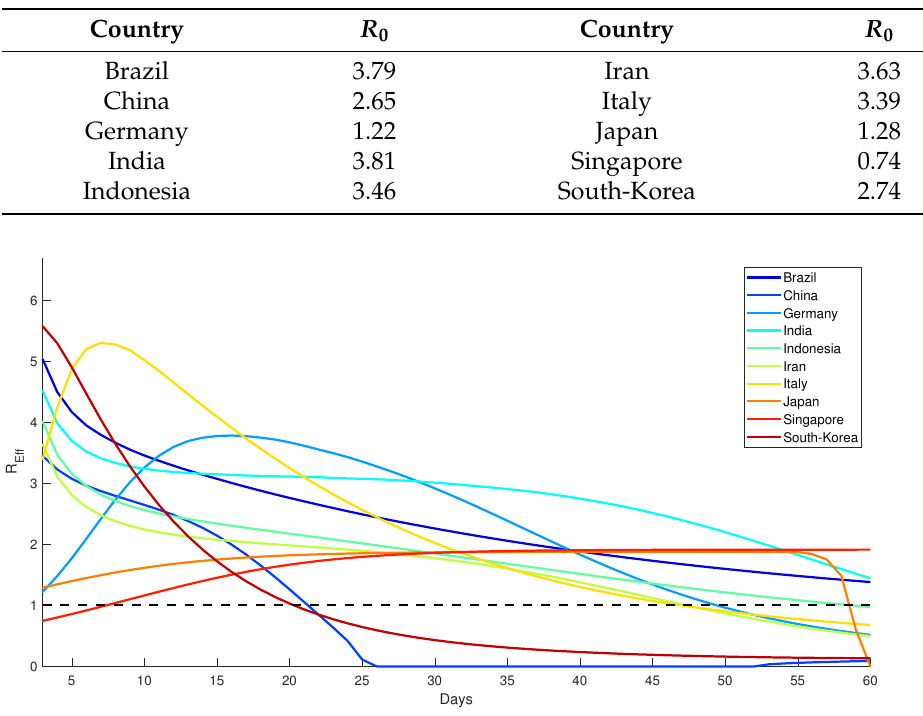
Figure 7. Dynamics of the effective reproduction number ( R 0 E ) for several